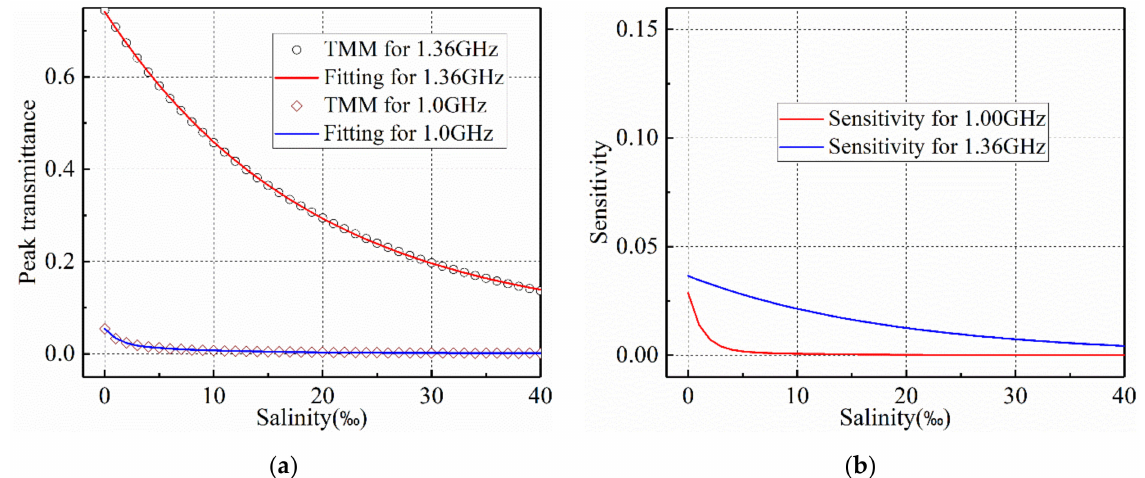
Figure 10. ( a ) Peak transmittance of the defective resonance and first transmitting mode, and ( b ) the detecting sensitivity of the peak transmittance versus salinity for the 15-layer defective MPC